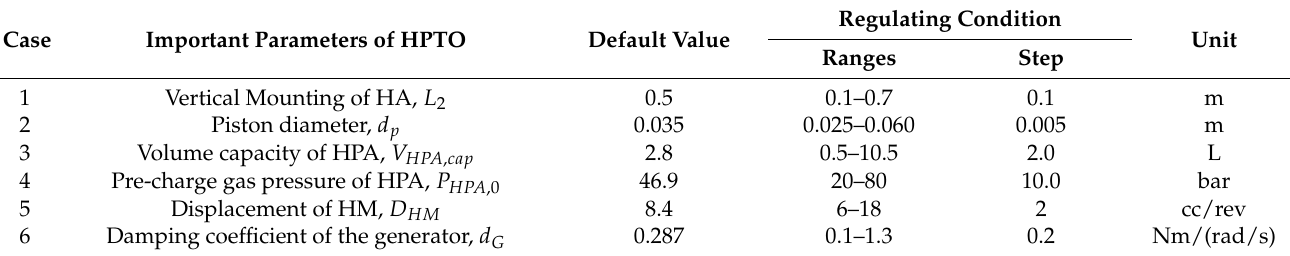
Table 4. Detailed of the case